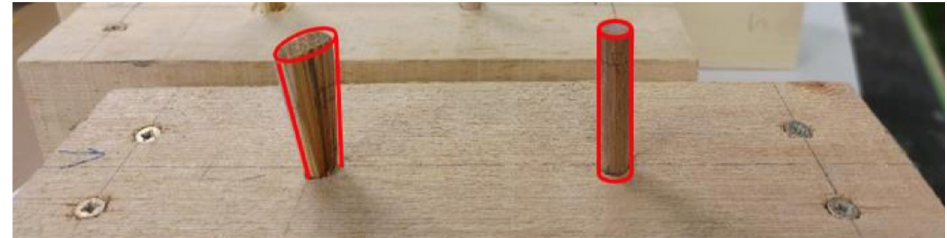
Figure 13. Set-recovery of a dowel made of densified Scots pine (left), and swelling of a non-modified European beech dowel after accelerated ageing [84].